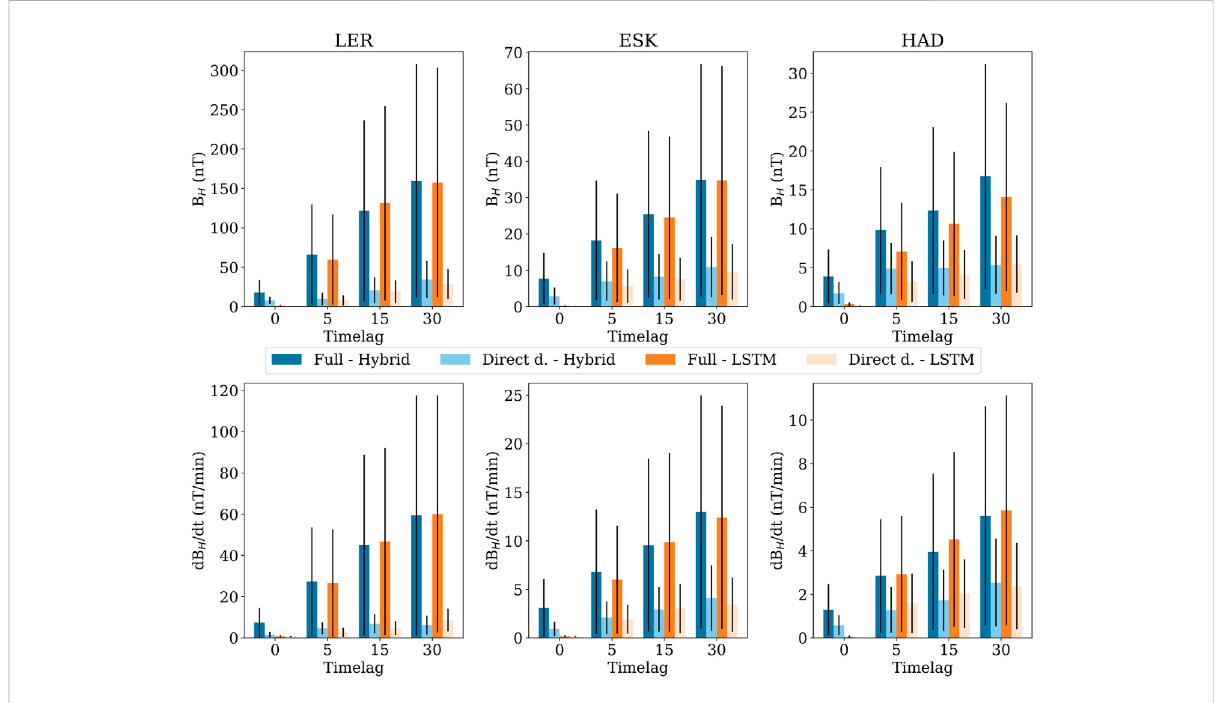
FIGURE 6 RMSEforeachmodelforecastingtheteststormateachTimelaginminutesLER,ESKandHAD.Bluecoloursrepresentthehybridmodel,orange colours represent the LSTM model. Error bars signify one standard deviation in the RMSE. Note the difference in y-scale in each